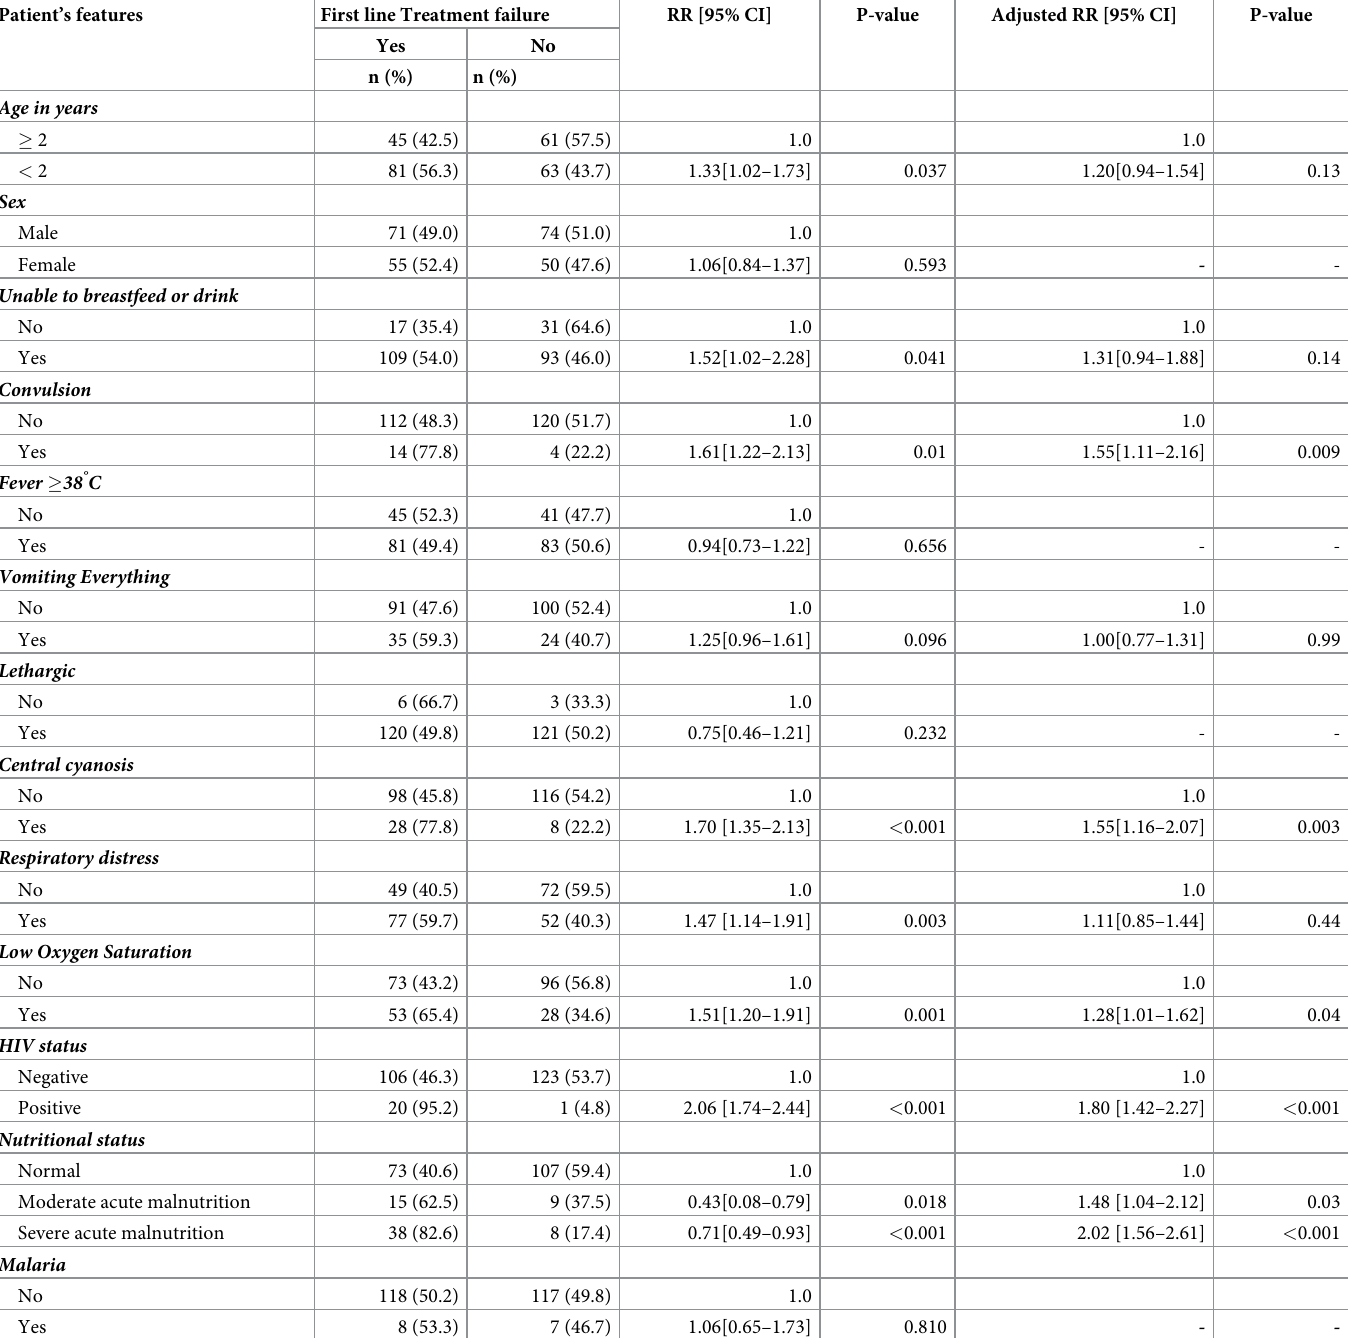
Table 2. Predictors of first line treatment failure among 250 children with severe community acquired pneumonia admitted at BMC from October 2013 to Febru- ary 2014. Patient’s